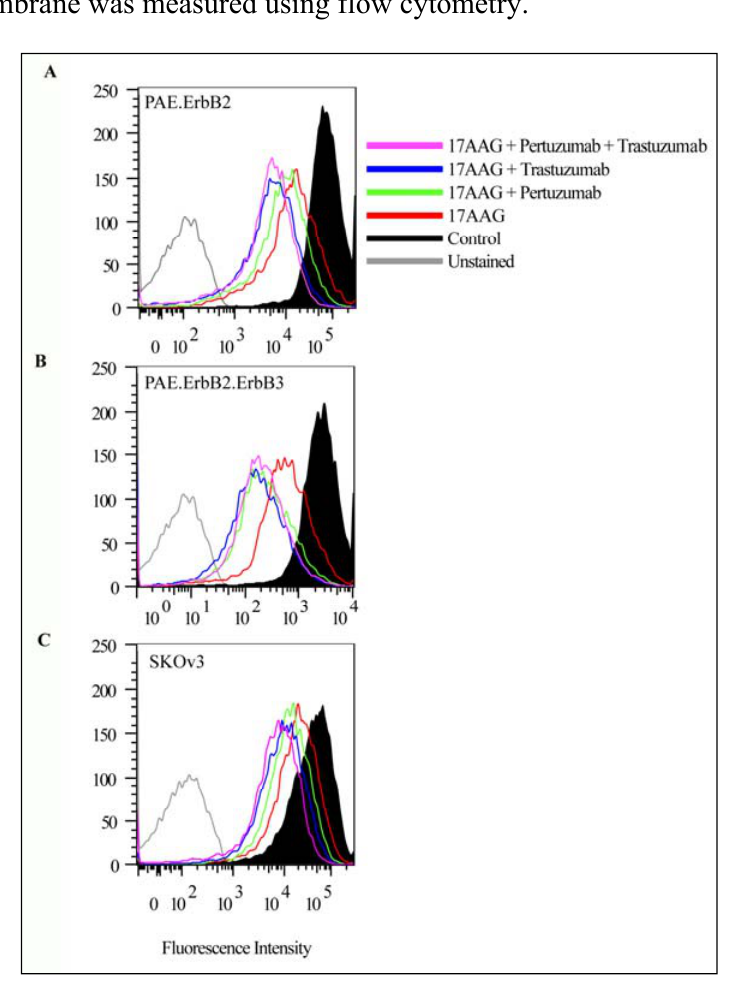
Figure 4. Incubation with pertuzumab and/or trastuzumab potentiates 17-AAG-induced down-regulation of ErbB2 from the plasma membrane. PAE.ErbB2 ( A ),